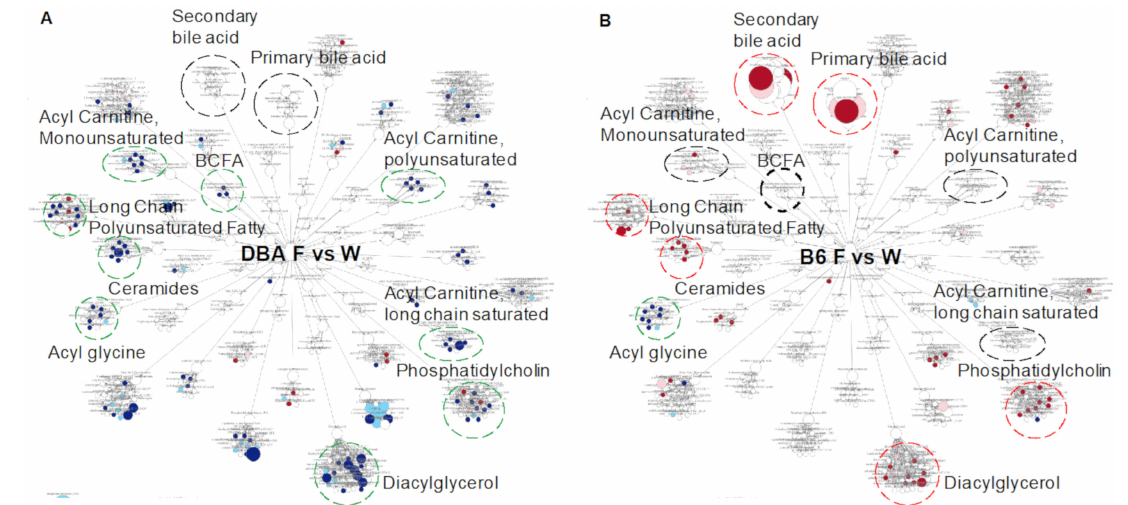
Figure 4. Plasma lipid pathways and metabolites altered by fructose consumption in DBA ( A ) and B6 mice ( B ). Dotted circles are lipid sub-pathways with contrasts between DBA and B6. Circles with red, green, black color indicate overall pathway level increase, decrease, or no change by fructose, respectively. Red and blue dots indicate lipid metabolites upregulated and downregulated at p < 0.05, respectively, in fructose-treated mice compared with controls. Pink and cyan dots indicate lipid metabolites upregulated and downregulated at 0.05 < p < 0.1, respectively. Dot size indicates the relative magnitude of change. n = 5–6/group. Statistical significance was determined by ANOVA